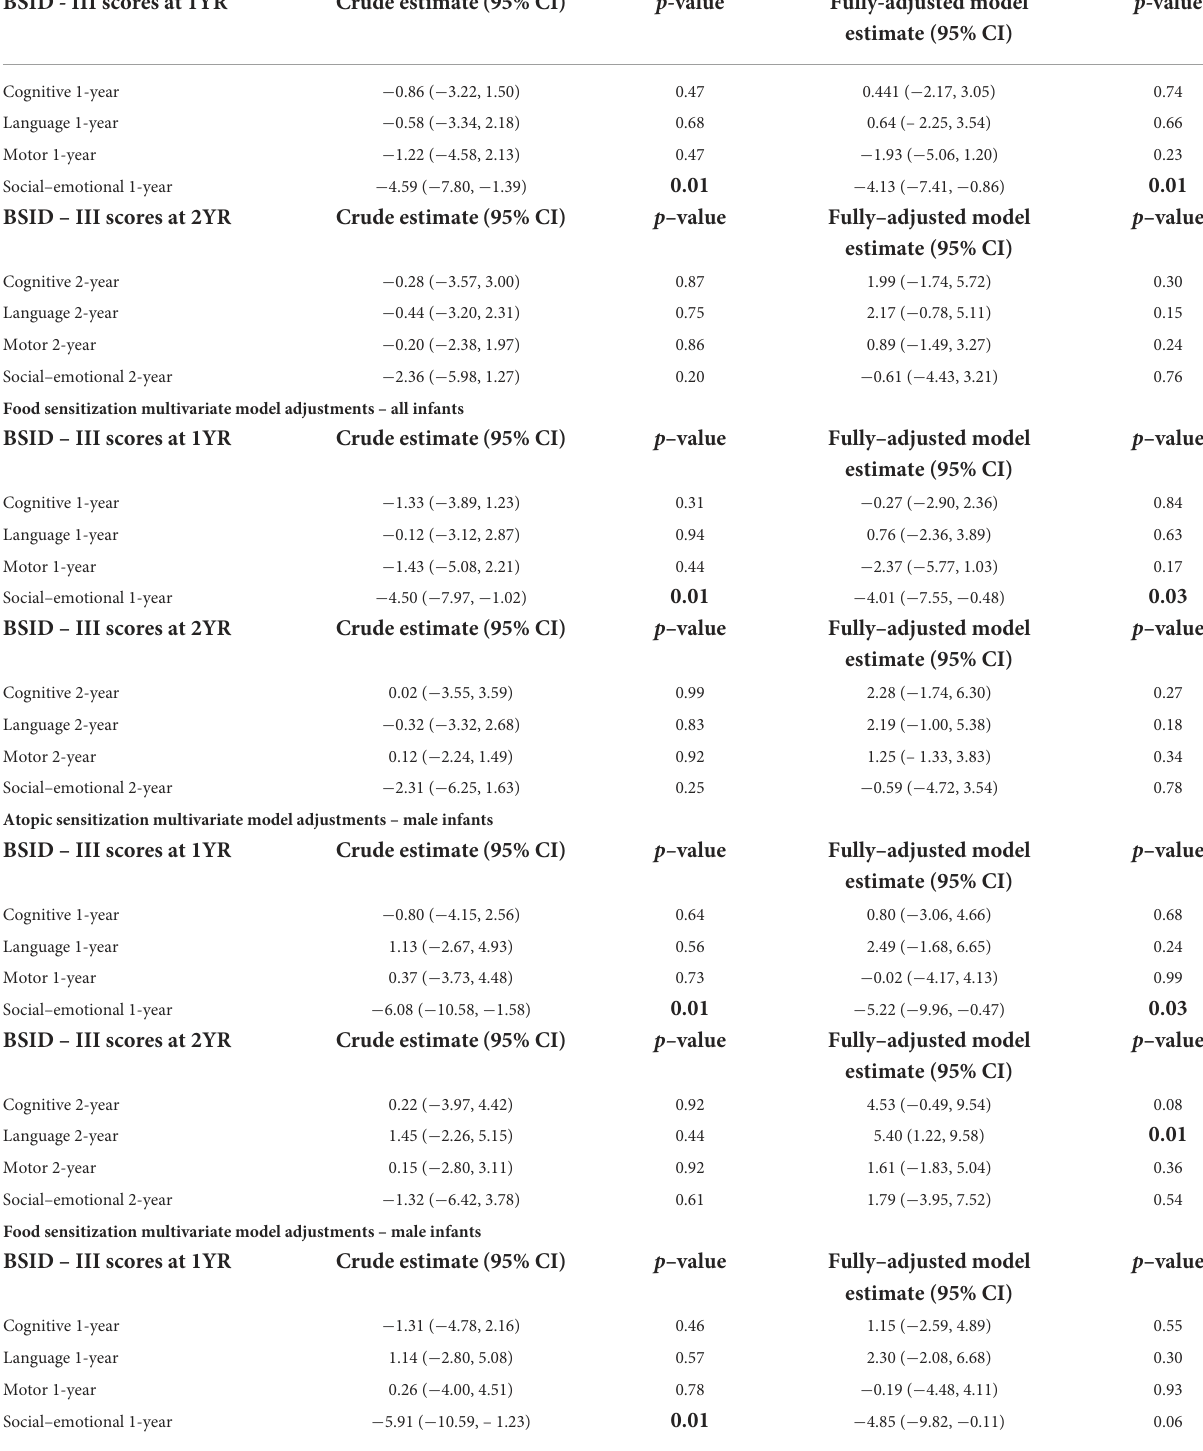
TABLE 2 Univariate and multivariate linear regression for sensitization at 1 year vs. social-emotional scores at 1 and 2 years, all infants and stratified by infant sex ( N = 537). Atopic sensitization multivariate model adjustments - all infants BSID - III scores at 1YR Crude estimate (95% CI) p -value Fully-adjusted model